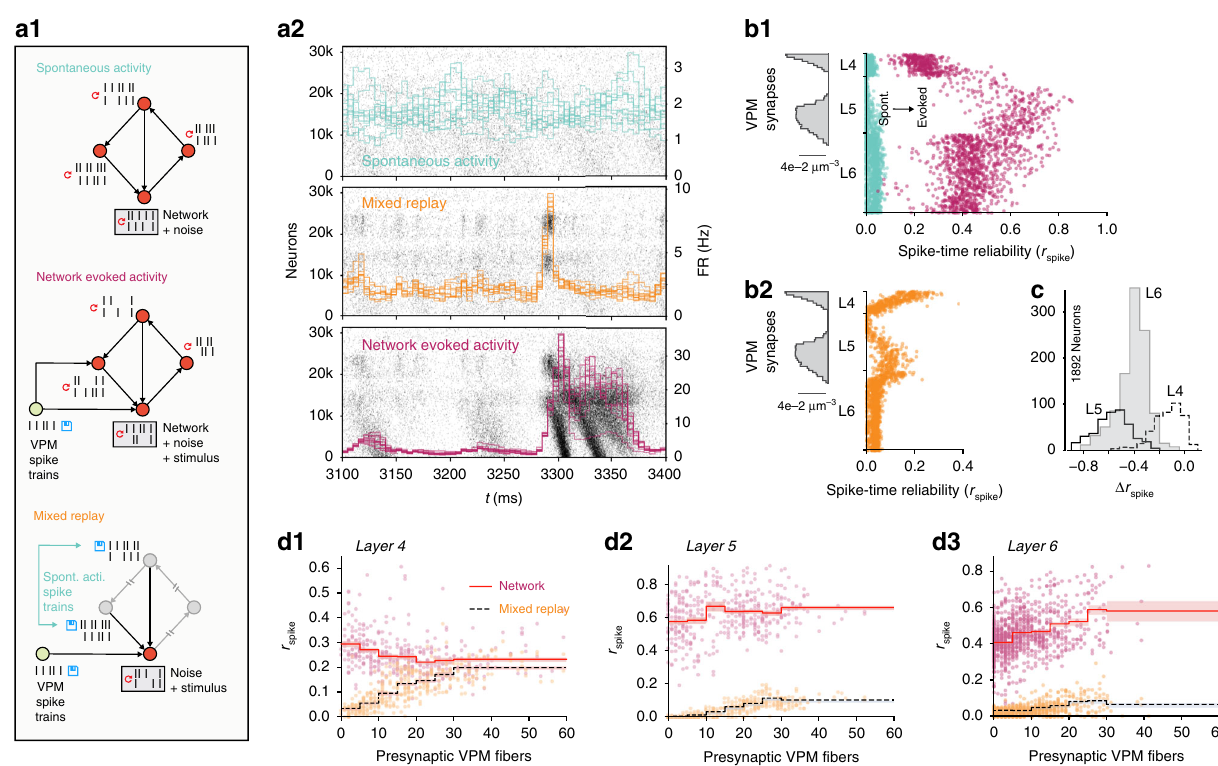
Fig. 7 High reliability requires recurrent cortical connectivity. a1 Overview of three simulation paradigms: spontaneous activity , network evoked activity (with network propagation intact and VPM input), and mixed replay (with network propagation replaced by replays of spontaneous activity spike trains, and VPM input). a2 Examples of population spiking activity during the three simulation paradigms. b1 Spike-time reliability, r spike , during spontaneous (blue) and evoked (purple) activity for 1675 excitatory neurons in the center of layers 4, 5, and 6. b2 Spike-time reliability, r spike , during a mixed replay with VPM input but with network propagation disabled for the same neurons as in b1 . c Difference in r spike between evoked activity with and without network propagation for 1892 excitatory neurons in the center of layers 4, 5, and 6 (same for d1 – 3 ). d1 The number of presynaptic VPM fi bers from which each neuron receives input vs. r spike in evoked simulations with ( network ) and without ( mixed replay ) network propagation. All reliabilities per neuron (points) are based on 30 trials. Mean of neurons per bin indicated by line; shaded area depicts standard error of mean of neurons in bin. Bins: 0 – 4, 5 – 9, 10 – 14, 15 – 19, 20 – 24, 25 –